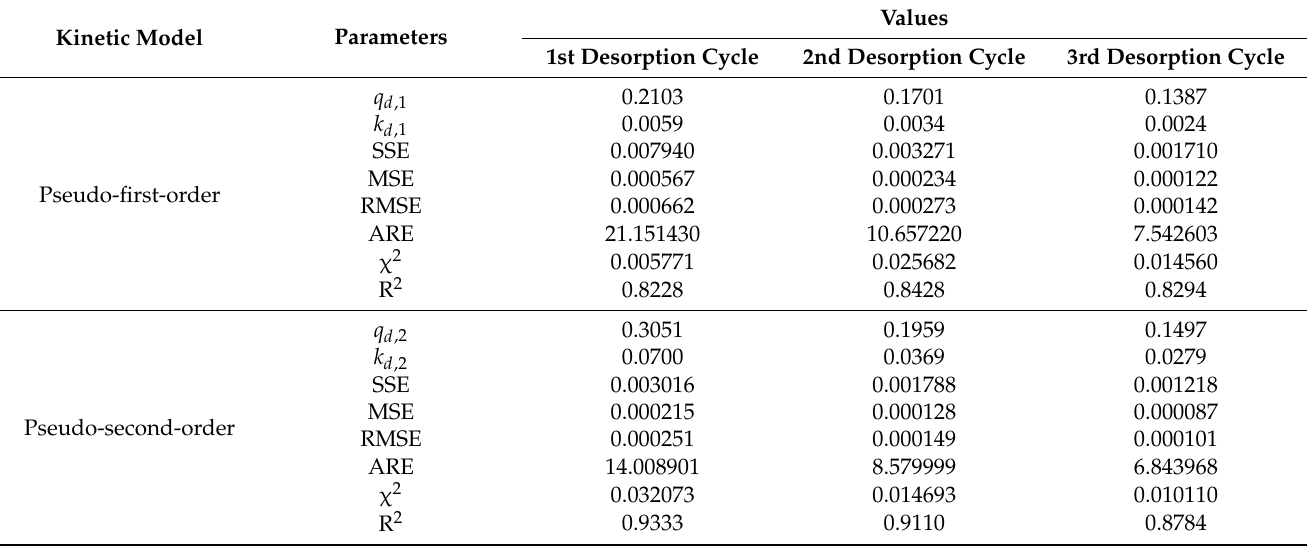
Table 3. Kinetic parameters and statistical functions of Reactive Black 5 dye desorption from